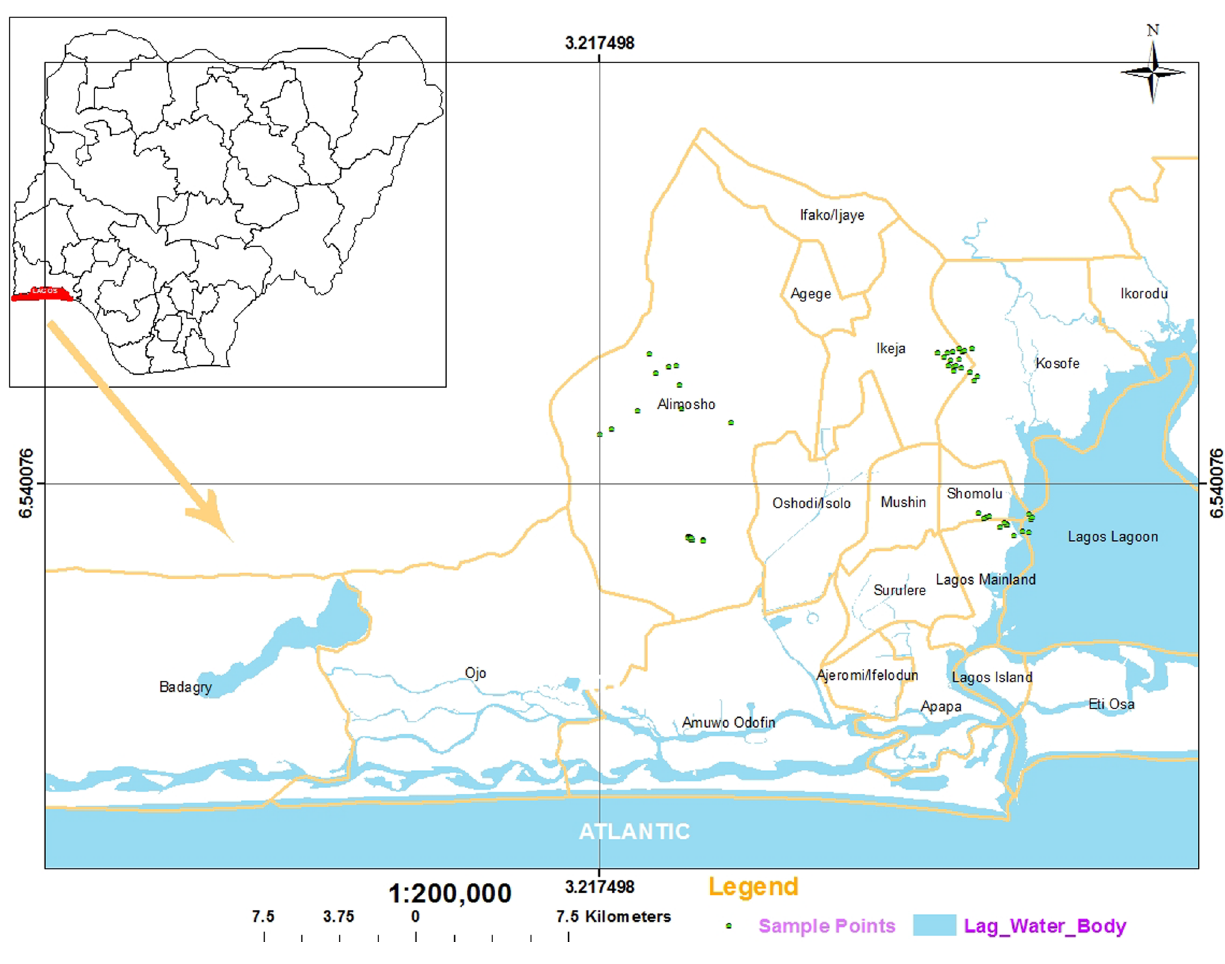
Fig.1 Sample location map of the study